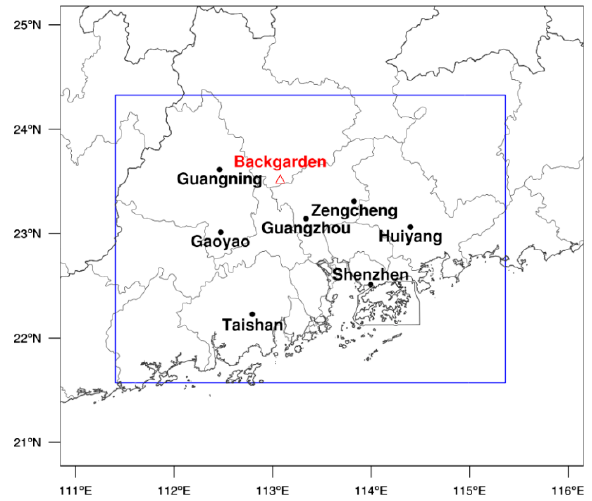
Figure 2. The domain of Weather Research and Forecasting (WRF) and Community Multiscale Air Quality (CMAQ) modeling (black frames: WRF modeling domain, blue frames: CMAQ modeling domain, black dots: surface meteorological sites, red triangle: the surface intensive observation site). Table 1. The configuration of physical parameterization for WRF